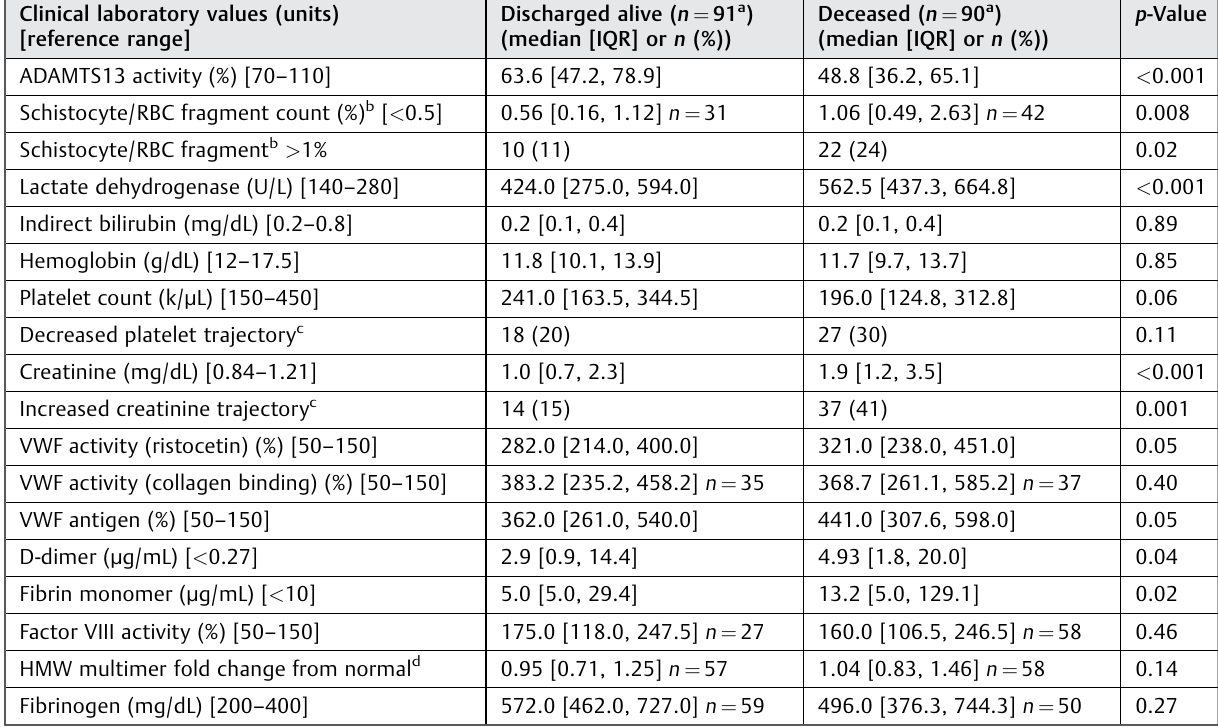
Table 2 ADAMTS13 activity levels and concurrent markers of endothelial activation, intravascular hemolysis, coagulation, and organ damage of 181 patients with COVID-19 strati fi ed by mortality outcome Clinical laboratory values